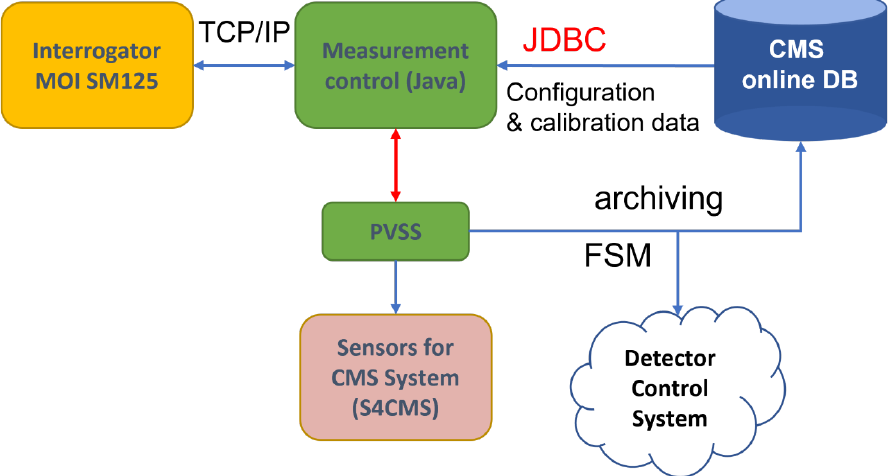
Figure 21. Integration of the FBG data taking system in the CMS Detector Control System.